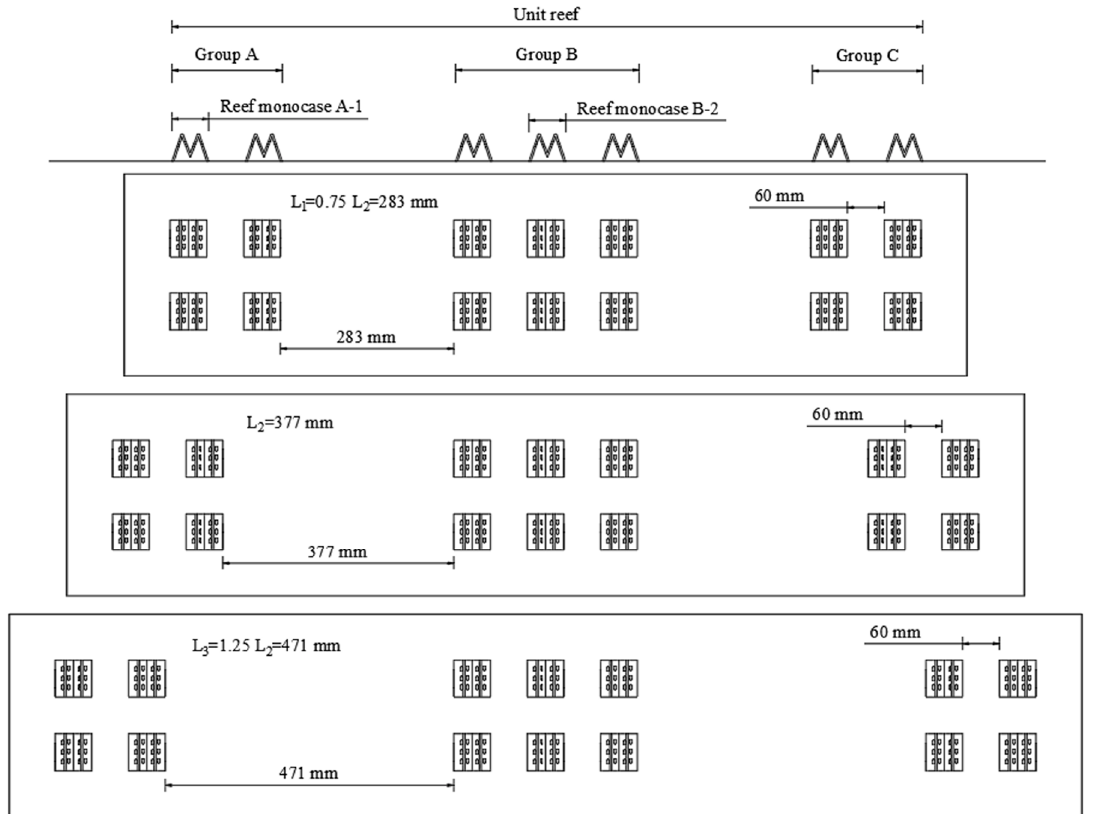
Figure 5. Three geometrical configurations of artificial reefs in the present experimental work.